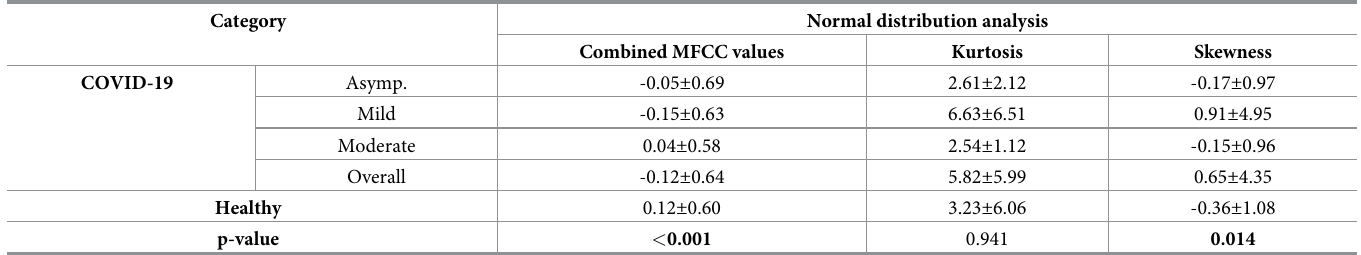
Table 3. Normal distribution analysis (mean ± std) of the combined mel-frequency cepstral coefficients (MFCCs) using the deep breathing dataset.